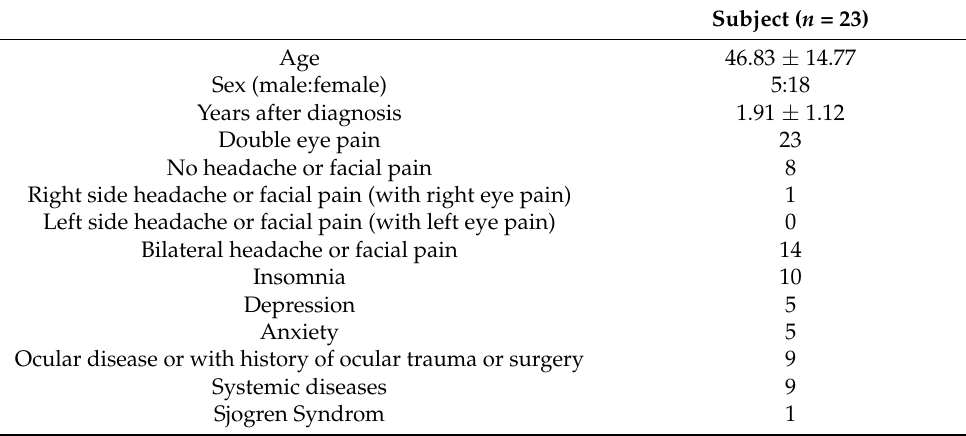
Table 1. Demographics of